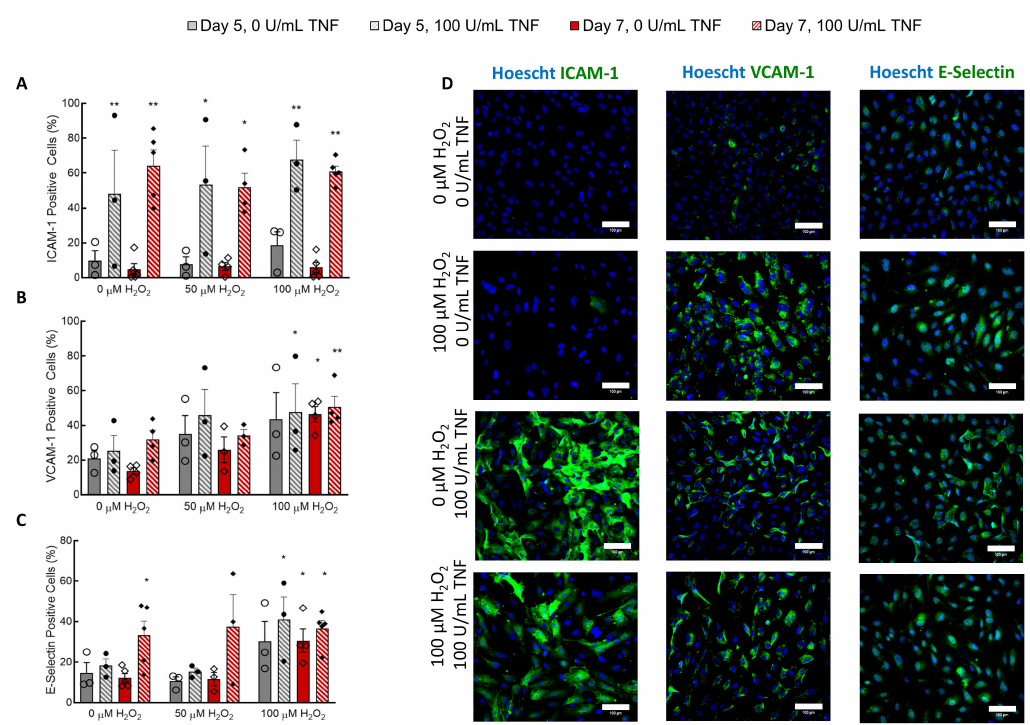
Figure 2. H 2 O 2 treatment induced VCAM-1 and E-selectin expression in ECFCs. ( A ) TNF- α increased ICAM-1 expression ( p < 0.0001), but H 2 O 2 treatment did not a ff ect ICAM-1 expression. ( B ) Both TNF- α and H 2 O 2 a ff ected VCAM-1 expression ( p < 0.05). Post-hoc analysis shows that 7-day treatment with 100 µ M H 2 O 2 with or without TNF- α caused a significant increase in VCAM-1 expression. Five-day treatment with H 2 O 2 caused a significant increase in VCAM-1 expression when combined with a 24-h dose of TNF- α . ( C ) Both TNF- α and H 2 O 2 a ff ected E-Selectin expression ( p < 0.05). Seven-day treatment with 100 µ M H 2 O 2 caused a significant increase in E-Selectin expression with or without TNF- α treatment. ( D ) Immunofluorescence was used to obtain the results presented in A–C. Images show cells imaged on Day 7. Scale bars represent 100 µ m. * p < 0.05 compared to 0 µ M H 2 O 2 and 0 U / mL TNF- α for each day. ** p < 0.005 compared to Day 5 0 µ M H 2 O 2 and 0 U / mL TNF- α . N = 3–5. Bars represents mean ±